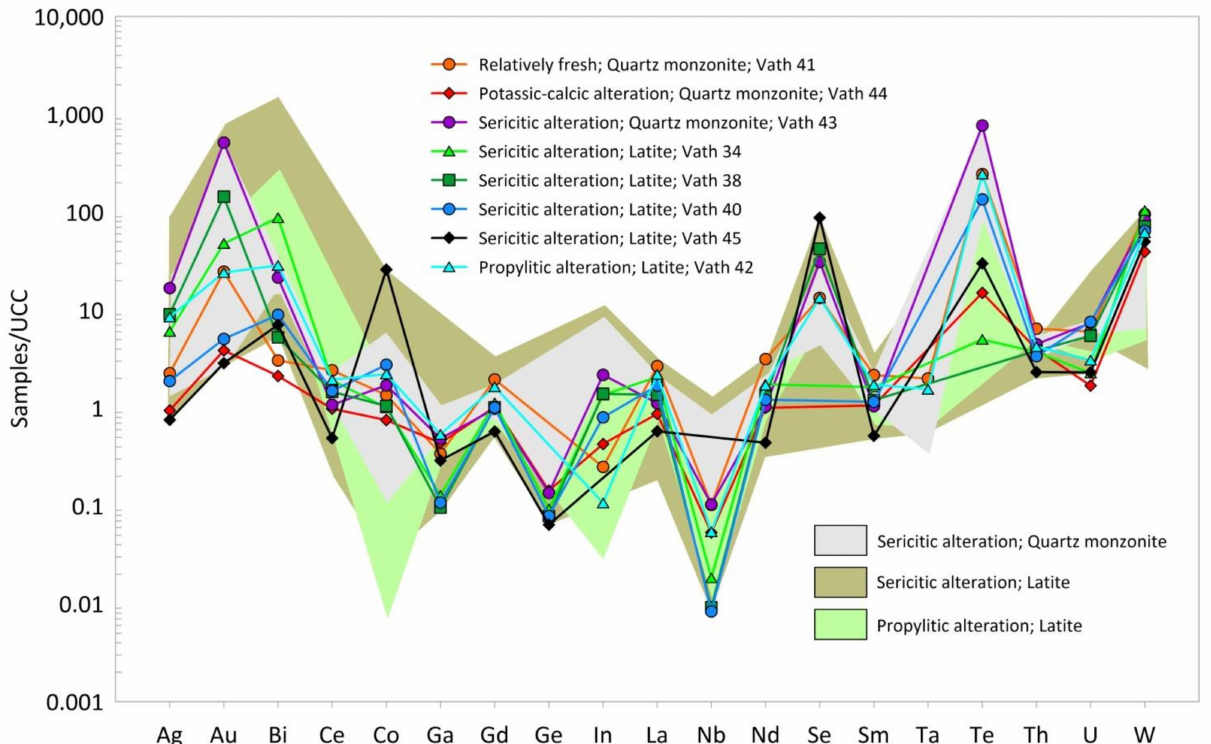
Figure 5. Upper continental crust (UCC) normalized logarithmic spider diagram of the eight analyzed samples presented in this study and the plot areas of previously analyzed samples by Stergiou et al. [53] corresponding to sericitic and propylitic alterations of quartz monzonite and latite (UCC normalized values after Rudnick and Gao